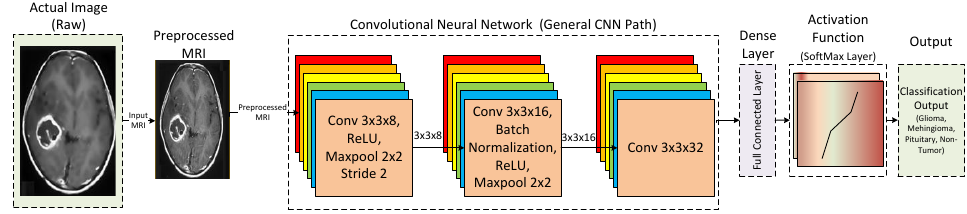
Figure 3. General architecture of a conventional CNN model.